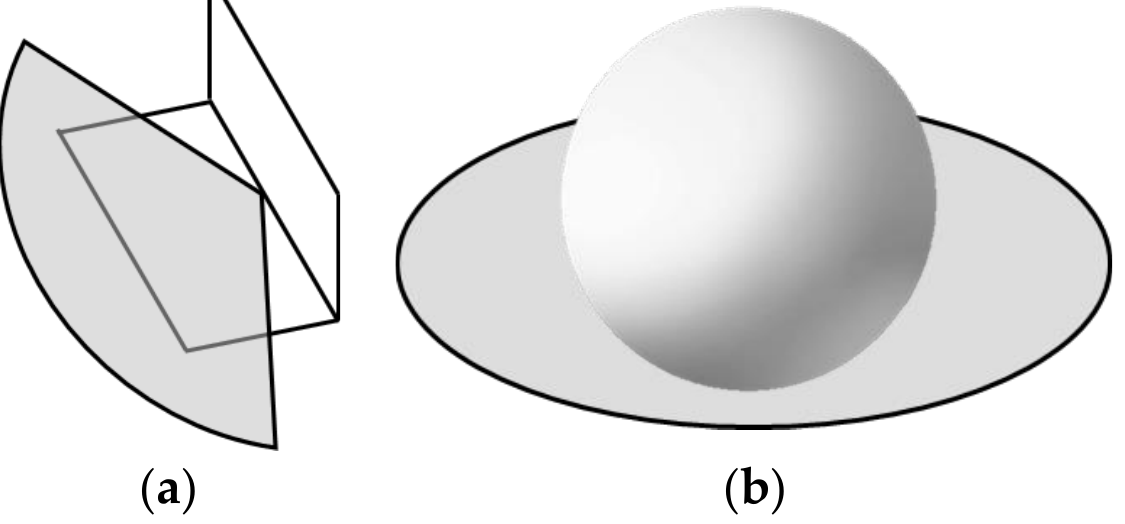
Figure 1. Comparison of the azimuth angle of different types of scatterers. ( a ) Dihedral corner reflector with more than 100-degree radar azimuth range. ( b ) Spheres reflector with 360-degree radar azimuth range.